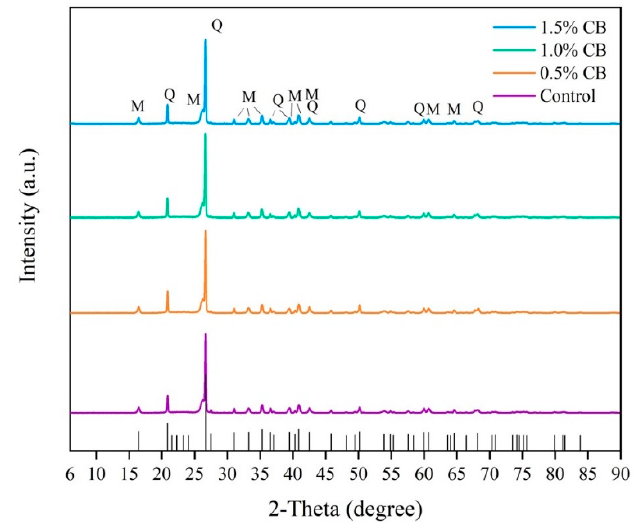
Figure 3. XRD analysis of tile samples sintered at 1200 ◦ C (Q: quartz and M: mullite).